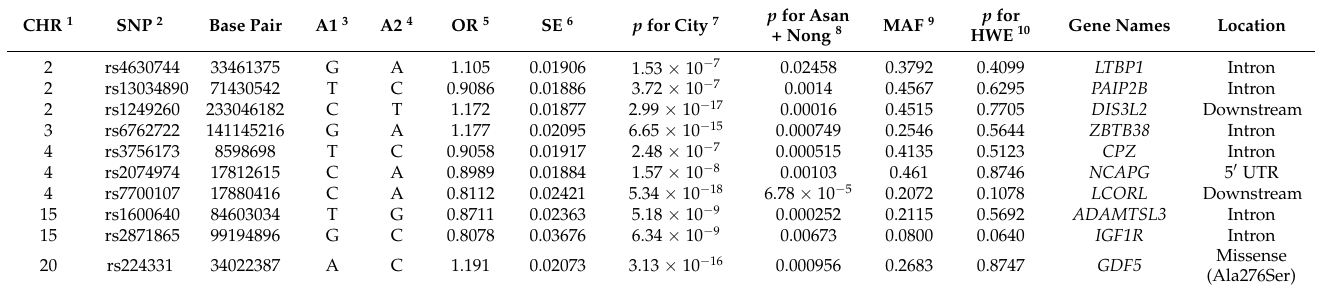
Table 3. Characteristics of genetic variants related to adult height from GMDR